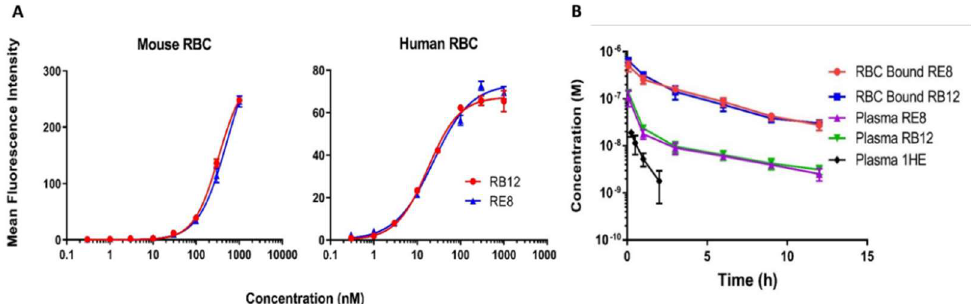
Figure 2. Characterization of Binding Affinity and Pharmacokinetics of Anti-RBC Single-Domain Antibodies. ( A ) The binding affinity of the anti-RBC RB12 and RE8 clones was assessed via flow cytometric analysis. Human and mouse RBCs were incubated with purified sdAbs. Binding activity was detected with a phycoerythrin-conjugated anti-His tag and quantified as mean fluorescence intensity (MFI). Data analysis was carried out using FlowJo software, and the calculated MFI was fitted with a specific binding function with Hill slope in GraphPad Prism software. Both clones showed high binding affinity to human RBC with the estimated K D of 17.7 nM and 23.6 nM for RB12 and RE8, respectively. The binding affinity of these clones to mouse RBC was revealed to be lower than to human RBC, with the estimated K D of 335 nM and 528 nM for RB12 and RE8, respectively. ( B ) The concentration-time profile after an IV administration of 1 mg/kg of RB12 and RE8 with a tracer dose of 125 I labeled is shown. RBC and plasma were separated from whole blood, TCA was precipitated, and radioactivity counted. Plasma PK data of a control sdAb with no known binding to mouse proteins (1HE) from a previous study in our lab was overlaid. Blood concentrations of the constructs were determined through gamma counting. Relative to 1HE, both RE8, and RB12 exhibited substantially improved persistence in plasma. Significant fractions of circulating RE8 and RB12 sdAbs are bound to RBC. Data points represent the mean concentration ( n = 3), and error bars denote the standard deviation of the mean.